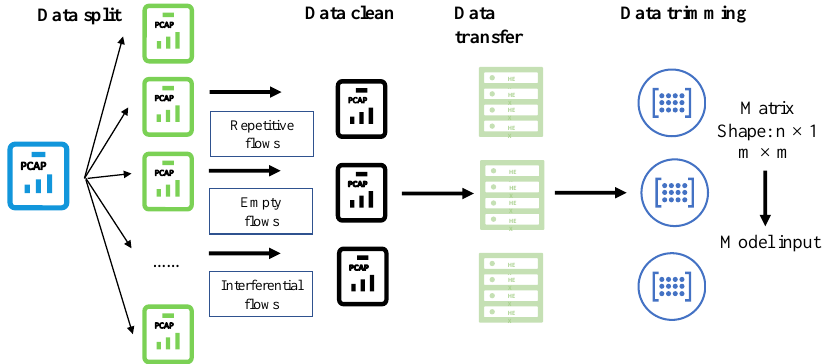
Figure 7. Data processing steps for PCAP files with data split, data clean, data transfer and data